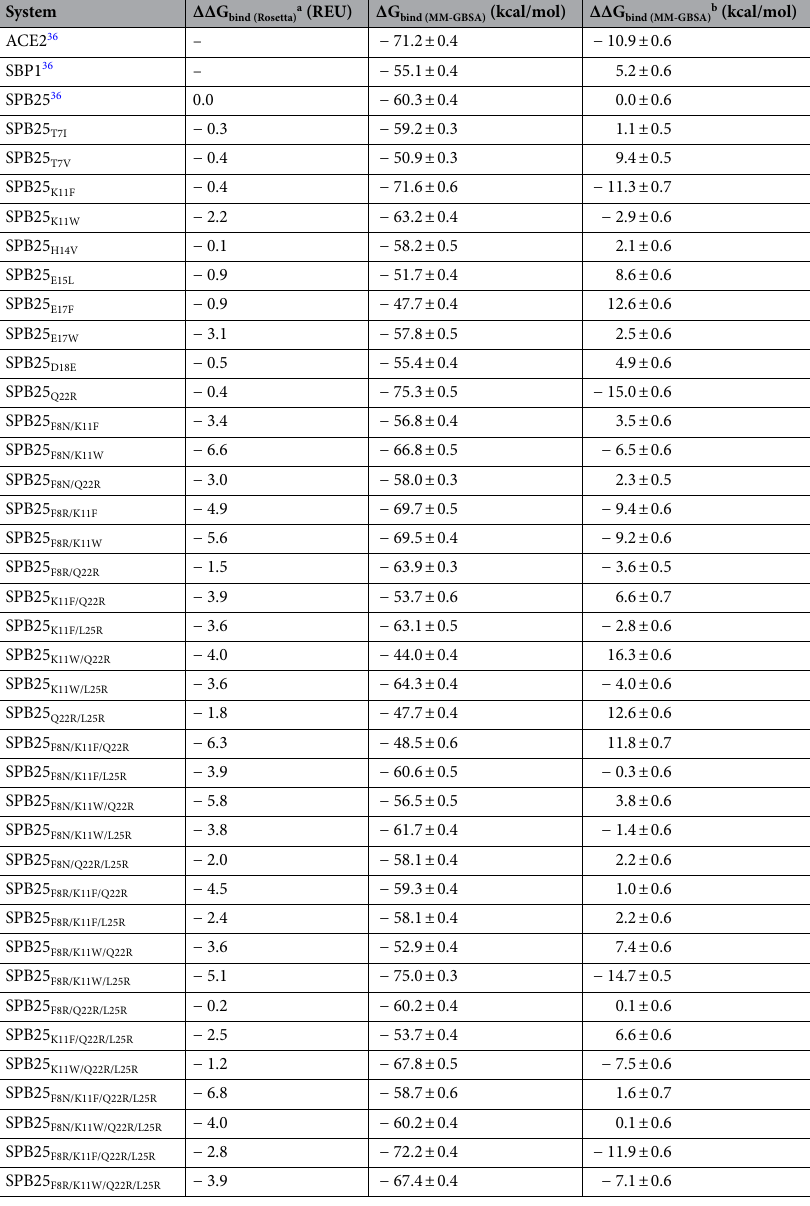
Table 1. The predicted binding free energies to SARS-CoV-2-RBD of ACE2, SBP1, SPB25 and designed peptides that were selected for MD simulations, as calculated by Rosetta and the MM-GBSA method. a The difference between ΔG bind (Rosetta) of a system and that of SPB25. b The difference between ΔG bind (MM-GBSA) of a system and that of